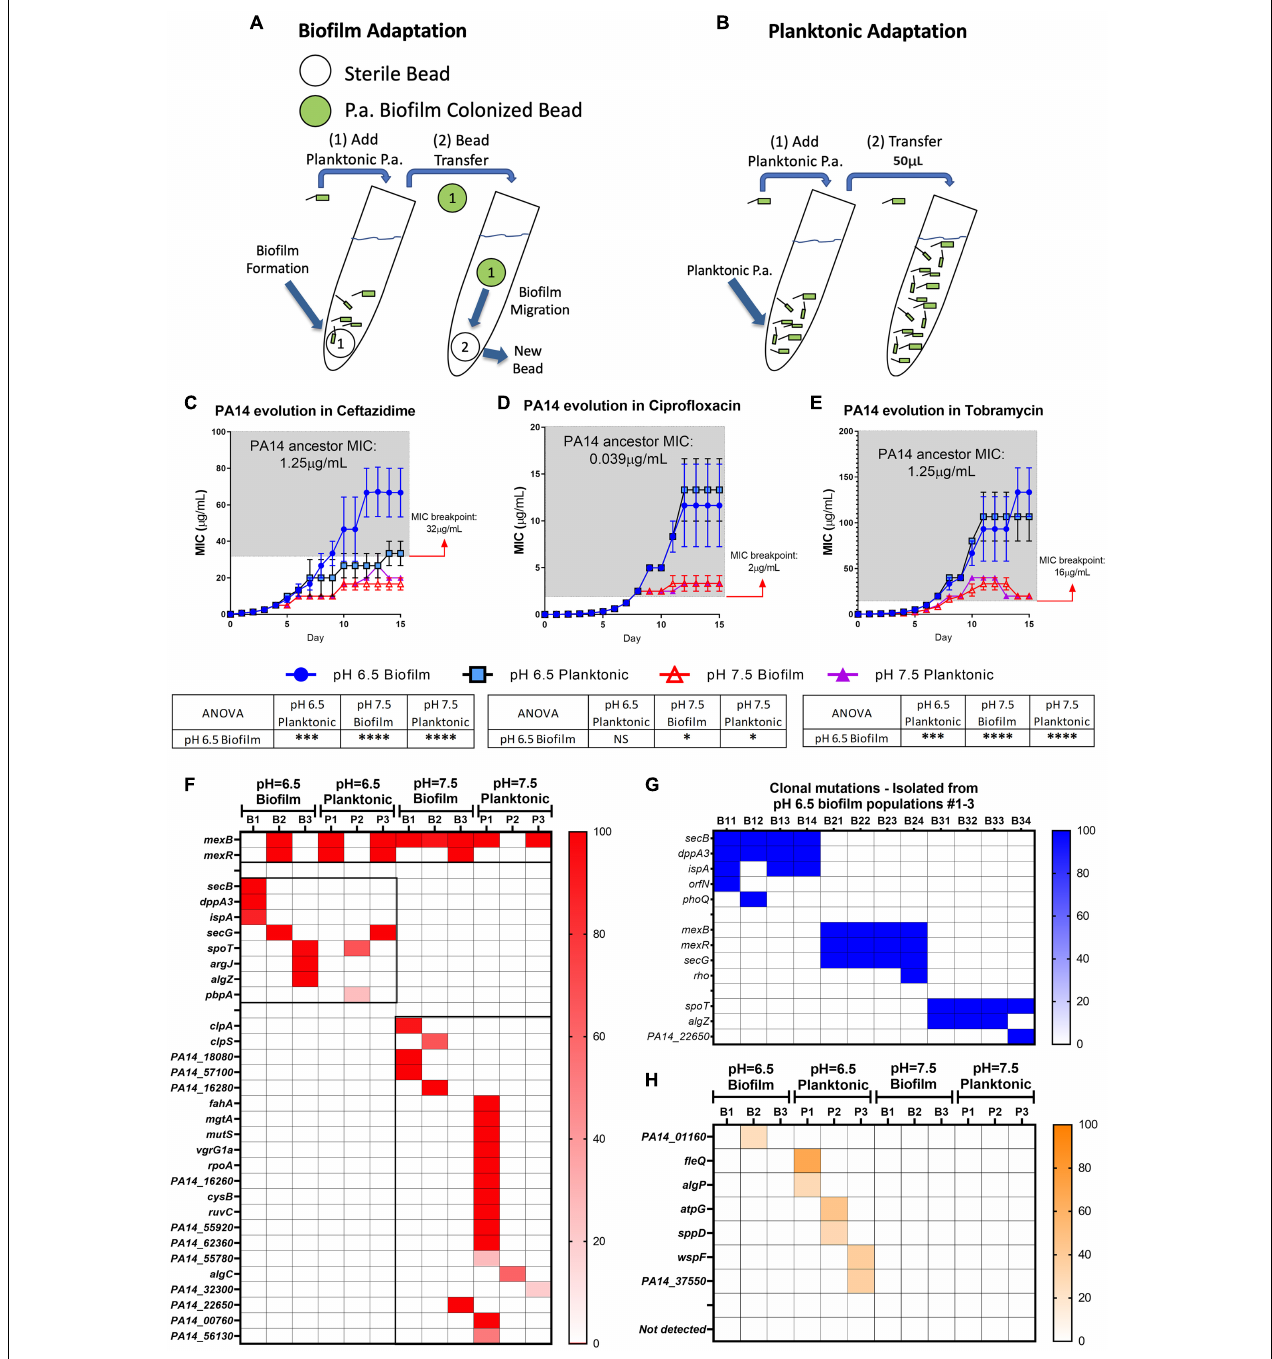
FIGURE 2 | Acidic pH promotes faster accumulation of adaptive resistance of P. aeruginosa against antibiotics compared to pH 7.5. (A,B) Schematics of the P. aeruginosa PA14 antibiotic adaptation experiment: biofilm on beads (A) and planktonic bacteria (B) were transferred to fresh m63 media (pH = 6.5/7.5, adjusted by HCl) every 24 h. (C–E) The PA14 biofilm/planktonic cultures were treated with 1/2 MIC at day 1. Antibiotic concentrations were doubled after every bead/planktonic transfer ( n = 3). The gray boxes on panels (C–E) denote MIC values that are considered antibiotic-resistant according to the guideline “MIC Breakpoints for Pseudomonas aeruginosa ,” published by The Clinical and Laboratory Standards Institute. (F) PA14 population mutations were identified after 15 days of evolution with ceftazidime. Each bacterial lifestyle/pH was evolved in triplicate populations. Biofilm (B)/planktonic (P) populations were labeled as B1, B2, B3, and P1, P2, P3, respectively. (G) Clonal mutations detected after 15 days of evolution with ceftazidime. Clones were labeled from number 1 to 4 following their population number. For example, B11 represents biofilm population B1, clone #1. (H) Mutations from PA14 evolution without antibiotics for 15 days. Color scale bars represent mutation frequency, which ranges from 0 to 100%. Data are mean ± SEM. One-way ANOVA was performed by comparing the combined day 14 and 15 MIC values. ∗ p < 0.05; ∗∗∗ p < 0.001; ∗∗∗∗ p < 0.0001; NS, not significant.